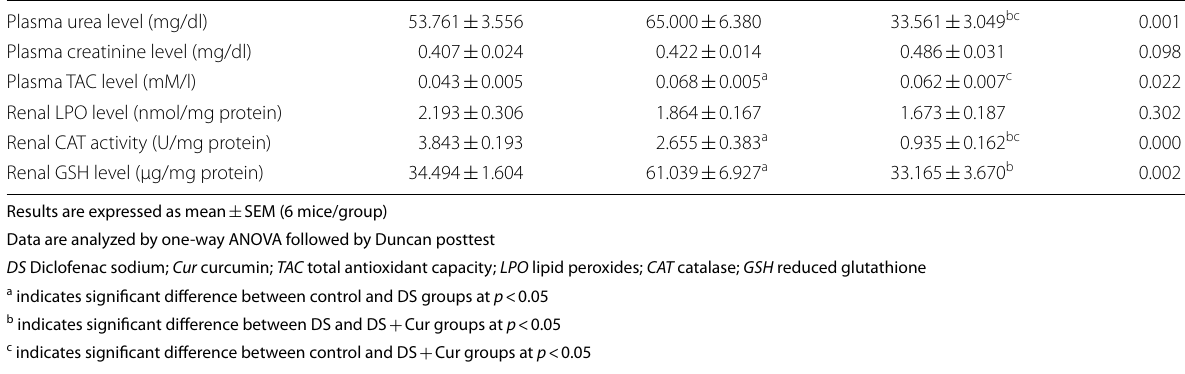
Table 1 Effects of curcumin on kidney function parameters and oxidant/antioxidant balance of diclofenac sodium‑challenged mice